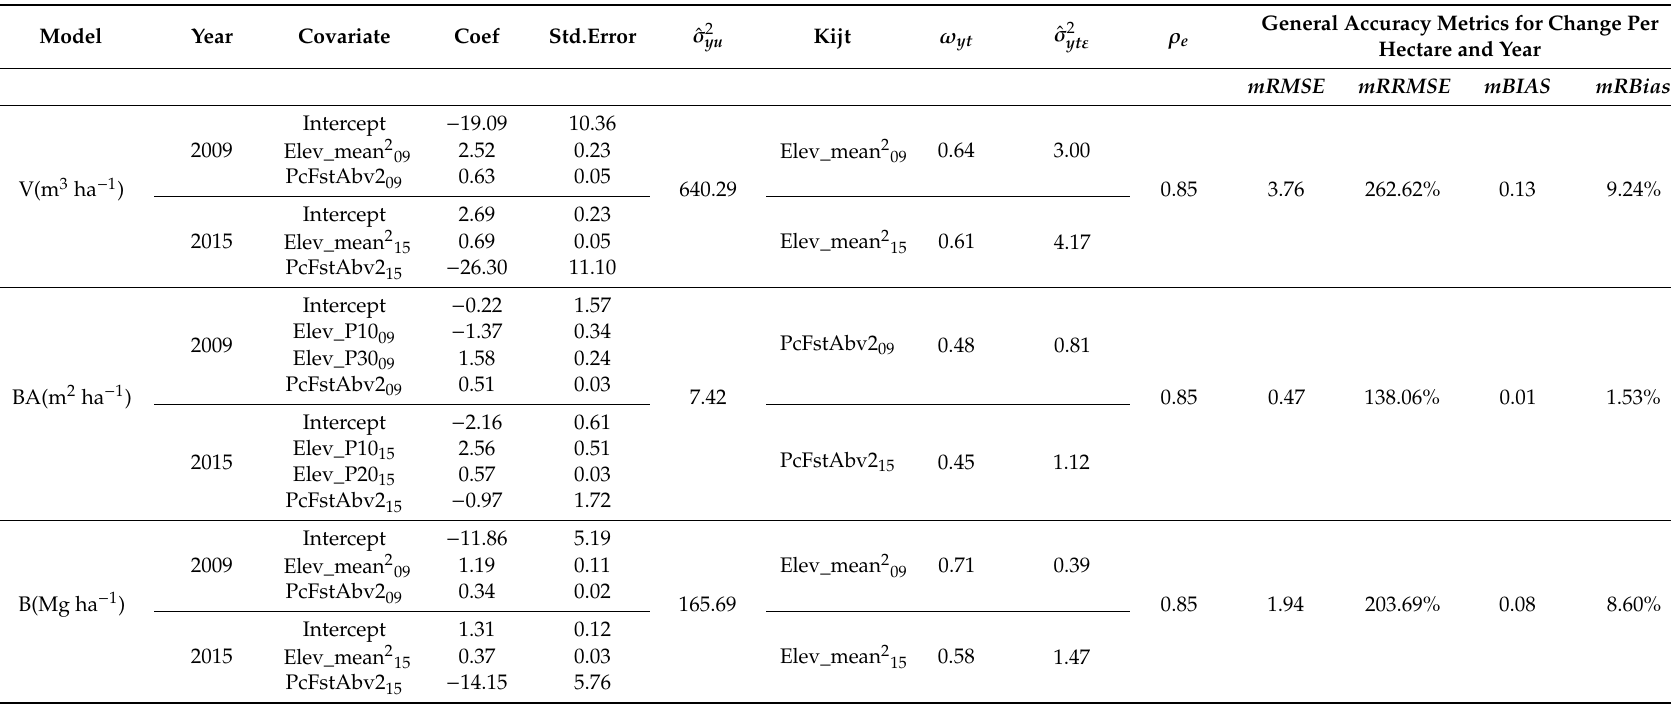
Table 3. Summary models for the y -modeling method. Model coe ffi cients, standard errors of the model coe ffi cients, variance-covariance parameters and general metrics for accuracy assessment are provided. Covariate acronyms are explained in Table A1. Coef is the value of the coe ffi cient and Std.Error its corresponding standard error. V indicates volume, BA indicates basal area and B indicates biomass. General Accuracy Metrics for Change Per